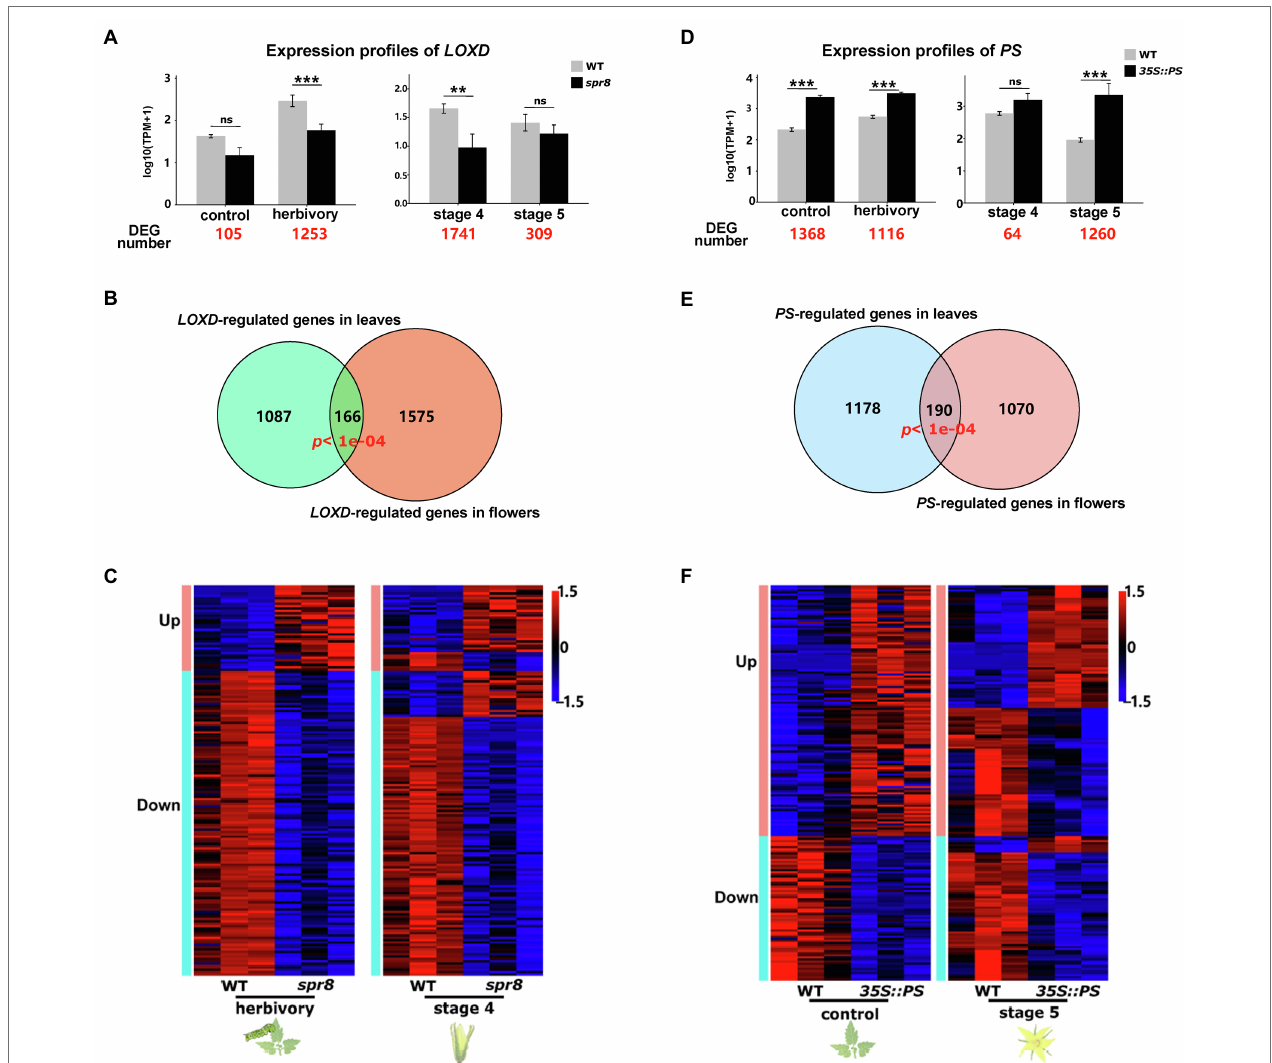
FIGURE 4 | The signalling machinery required for herbivory-induced responses is partially also involved in flower development. (A) Expression profile of LOXD in herbivore-infested leaves and untreated controls, as well as during flower development (stages 4 and 5) of WT (grey bars) and spr8 plants (black bars). The numbers highlighted in red represent the number of DEGs between WT and spr8 plants within each treatment or stage. (B) Venn diagram showing the overlap between LOXD -regulated DEGs observed in herbivory-infested leaves and during flower development at stage 4. p denotes the probability to obtain the observed overlap by chance and was analysed by permutation test, n = 10,000. (C) Heat maps showing the expression patterns of LOXD -regulated genes in both herbivory-infested leaves and during flower development (stage 4) in WT and spr8 plants. (D) Expression profile of PS in herbivore-infested leaves and untreated controls, as well as during flower development (stages 4 and 5) of WT (grey bars) and 35S::PS plants (black bars). The numbers highlighted in red represent the number of DEGs between WT and 35S::PS plants within each treatment or stage. (E) Venn diagram showing the overlap between PS -regulated DEGs observed in control leaves and during flower development at stage 5. p denotes the probability to obtain the observed overlap by chance and was analysed by permutation test, n = 10,000. (F) Heat maps showing the expression patterns of PS -regulated genes in both control leaves and during flower development (stage 5). Asterisks indicate differential expression of a gene between different genotypes in the same treatment or stage in (A) and (D) . Based on the criterion of DEGs (see Section ‘Materials and Methods’), ** denotes p ≤ 0.01 and *** denotes p ≤ 0.001; ns, not significant. Error bars indicate standard